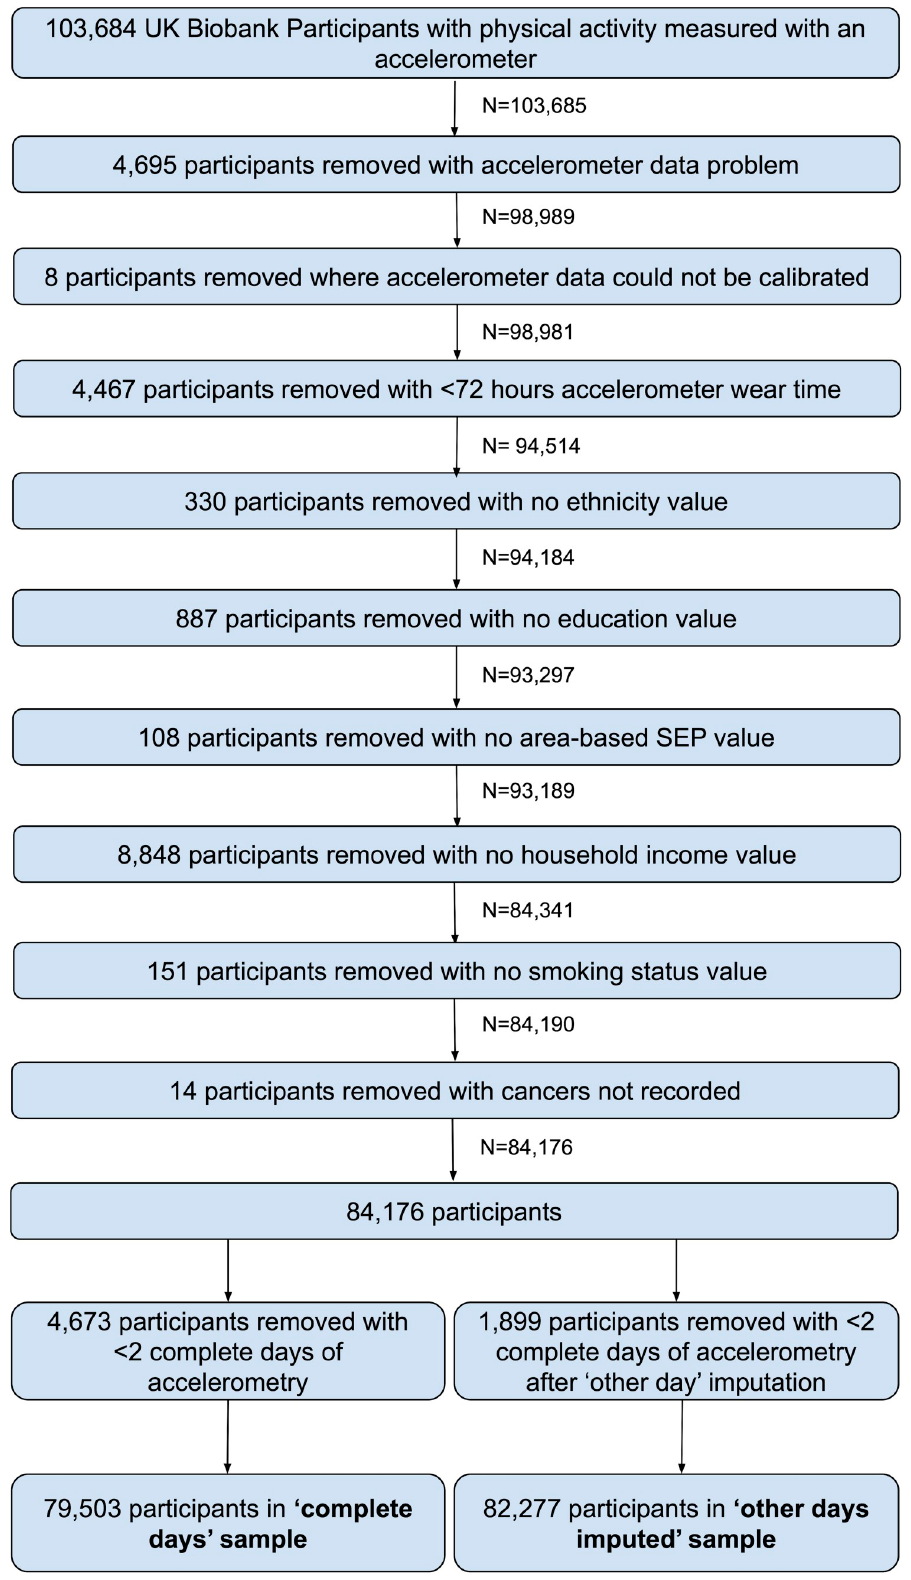
Fig 1. Participant flow diagram. S AU : PleasedefineSEPintheabbreviationlistofFig 1 ifapplicable = appropriate : EP, socioeconomic position.